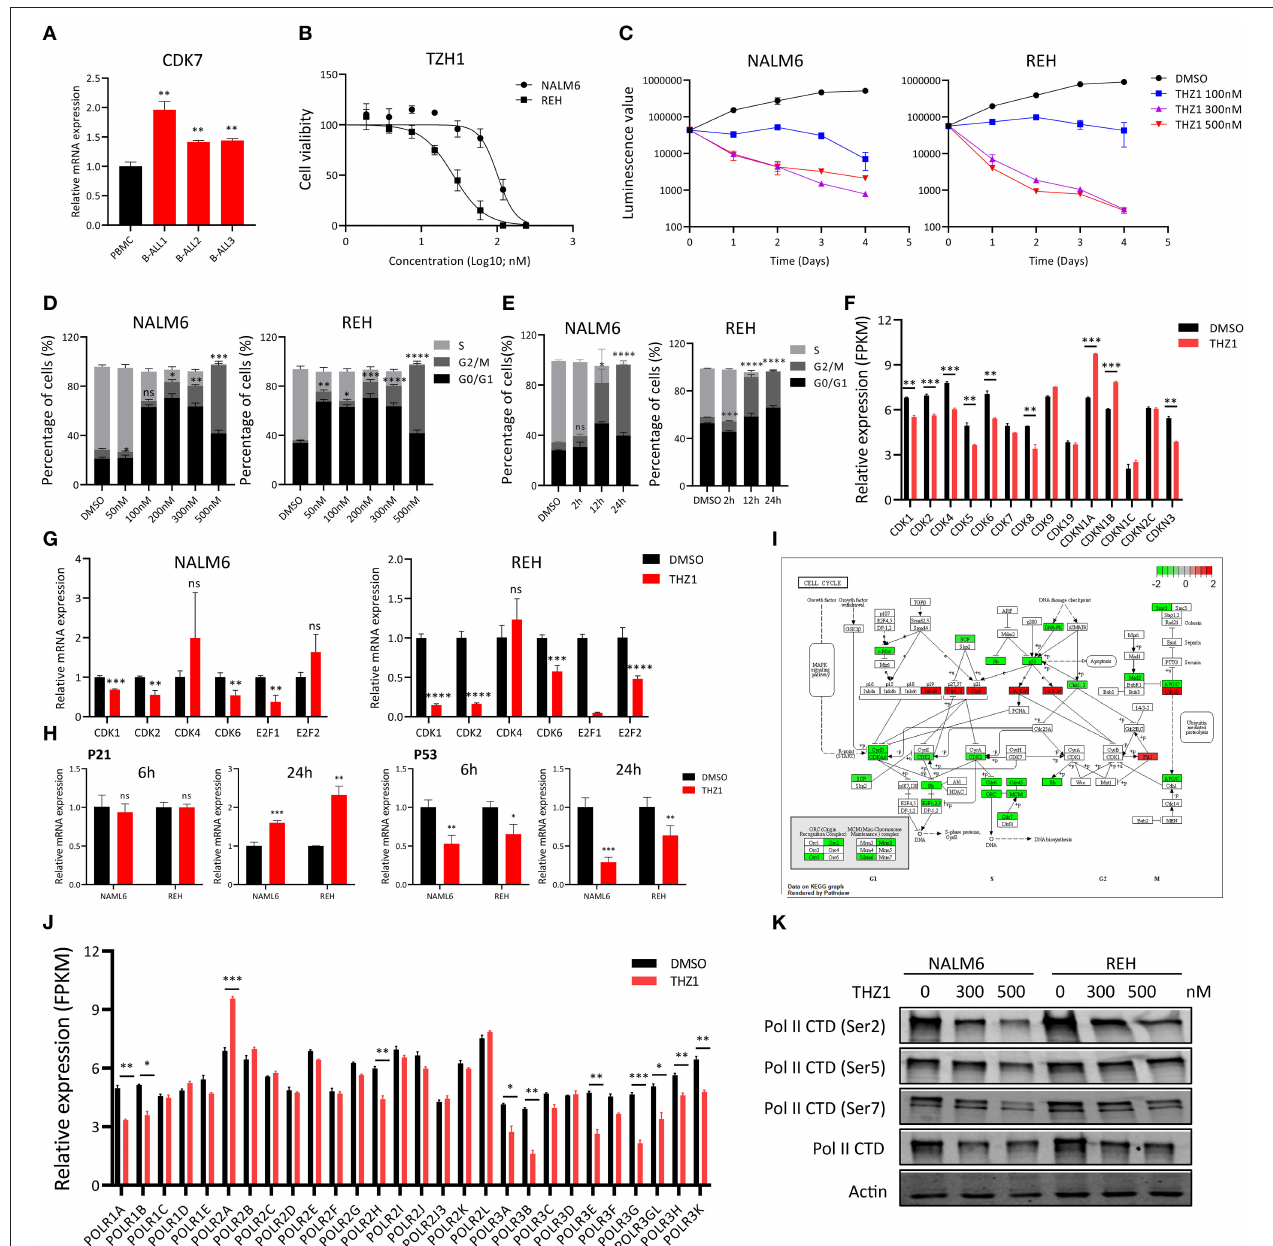
FIGURE 1 | THZ1 inhibits cell proliferation in B-ALL cells. (A) Relative mRNA expression of CDK7 in primary B-ALL sample and human PBMCs. (B) Drug sensitivity assay of NALM6 and REH cells after treatment with different concentrations of THZ1 for 72h. (C) Cell count assay of NALM6 and REH cells after treatment with different concentrations of THZ1. (D) EdU-labeled cell cycle of B-ALL cell lines was analyzed by flow cytometry after treatment with different concentrations of THZ1 for 24h. (E) Cell cycle of B-ALL cell lines was analyzed by flow cytometry after treatment with THZ1 for 2, 12, and 24h. (F) CDKs expression was detected by RNA-SEQ in THZ1- and DMSO-treated NALM6 cells. (G) The mRNA expression of CDKs and E2F family was measured by qRT-PCR in THZ1- and DMSO-treated B-ALL cells. (H) The mRNA expression of p21 and p53 was measured by qRT-PCR in THZ1- and DMSO-treated B-ALL cells. (I) Pathview analysis of down and upregulated cell cycle-related genes in THZ1-treated NALM6 cells. (J) The mRNA expression of the POLR family was assessed by RNA-SEQ in THZ1- and DMSO-treated NALM6 cells. (K) The protein expression of Ser2, Ser5, Ser7, and total RNAPII was determined by Western blot in THZ1- and DMSO-treated B-ALL cells. Values were shown as mean ± SEM. * p < 0.05, ** p < 0.01, *** p < 0.001, and **** p < 0.0001.